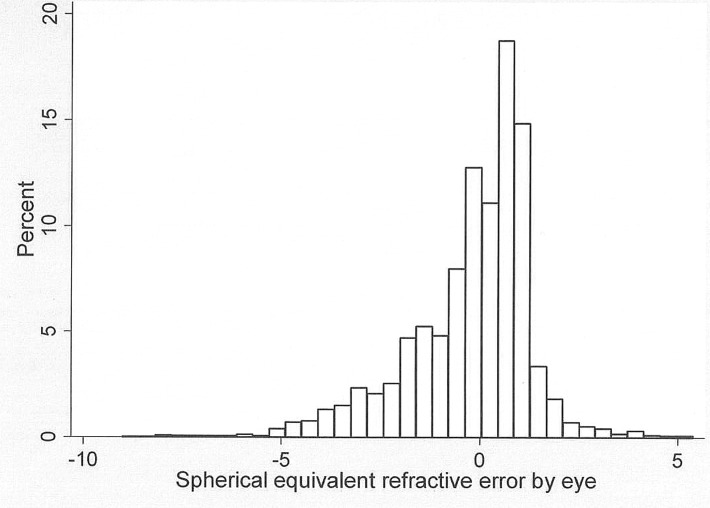
Distribution of spherical equivalent refractive error (Diopters) in 3804 eyes of 1902 children with complete data in the current study